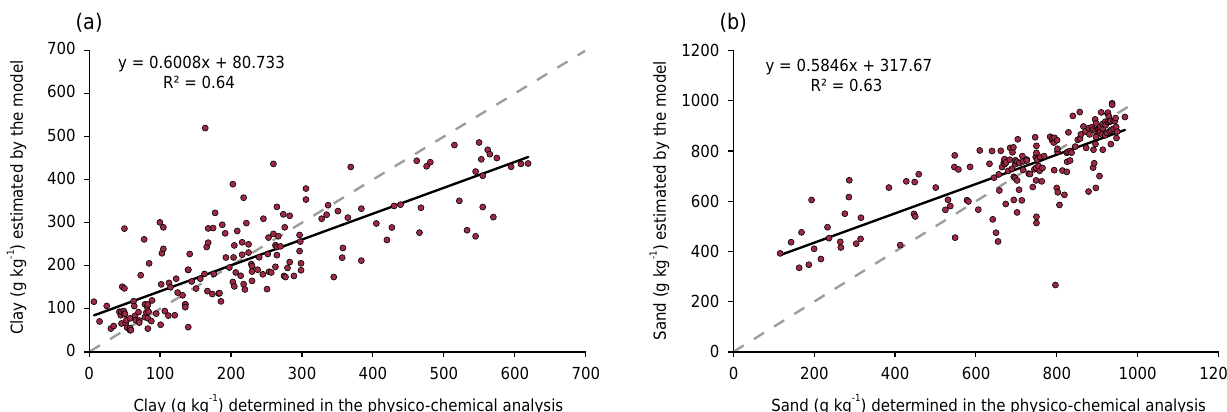
Figure 5. Coefficient of determination of the soil properties of Area 1 estimated by the equations generated from the reflectance data of the Landsat 7 sensor from the same area. The dotted line represents the ideal